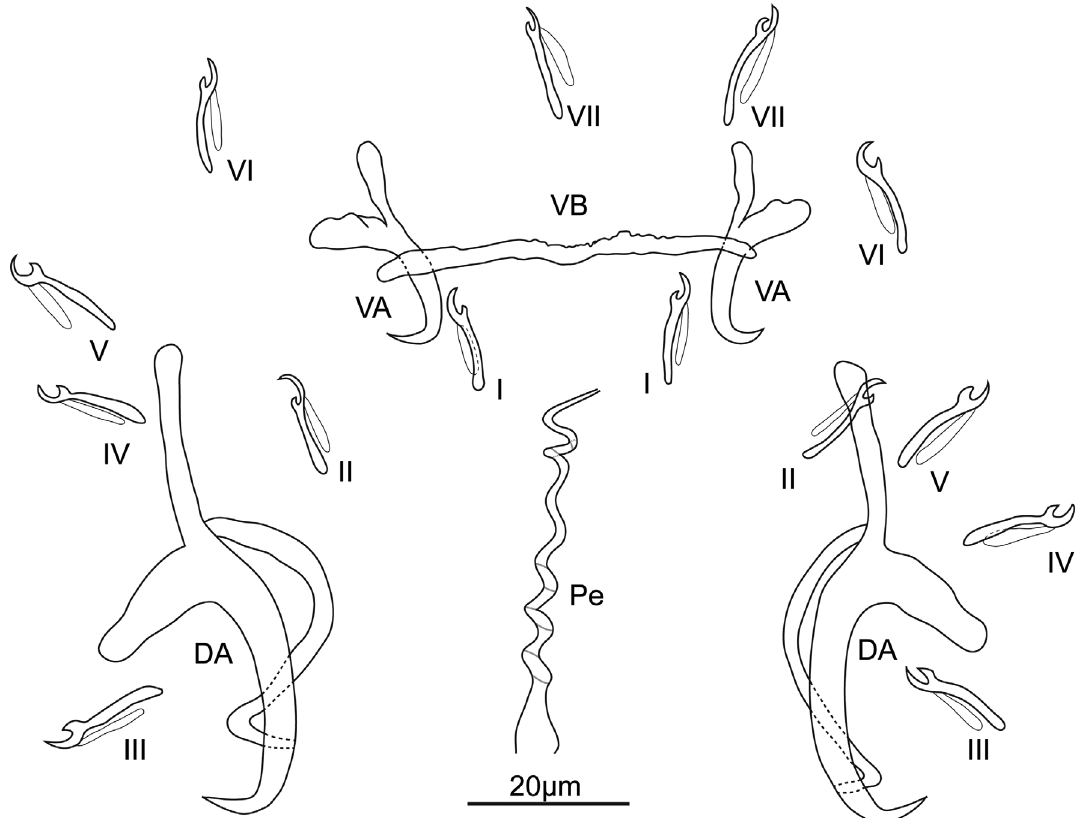
Figure 5. Drawings of sclerotized parts of E. malmbergi Bilong Bilong, 1988. DA, dorsal anchor; VA, ventral anchor; VB, ventral bar; Pe, penis; I – VII,